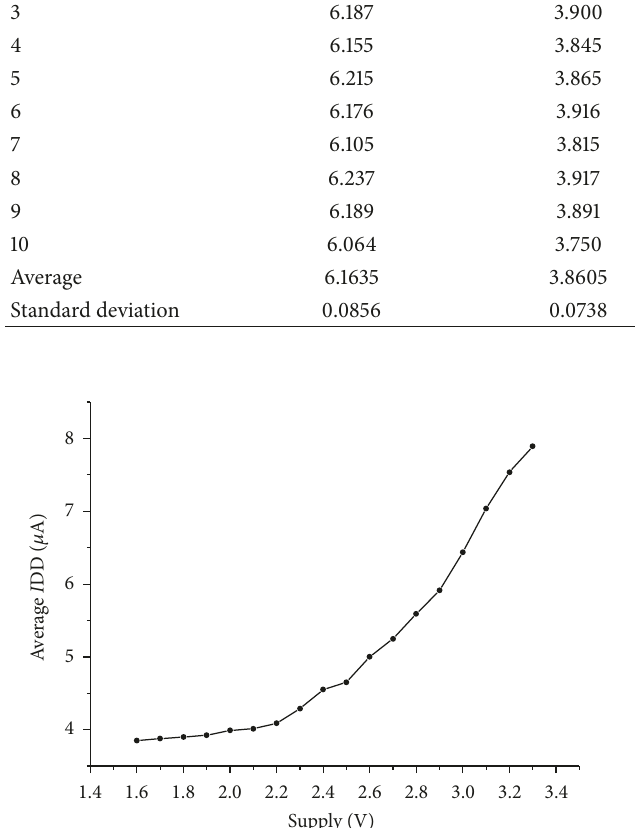
Figure 15: Testing results of power consumption at room tempera- ture.